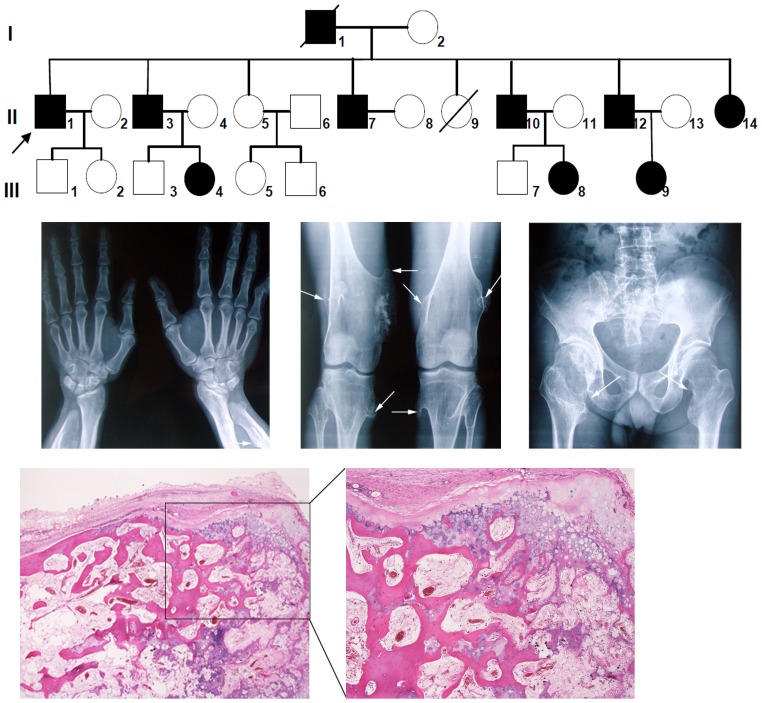
Hereditary and clinical features of a Chinese family with HME.(A) Pedigree of the family with HME. Arrow indicates the proband. Filled circles and squares indicate affected individuals. Open circles and squares indicate normal individuals. Oblique lines indicate the deceased. (B) Postero-anterior positioned radiograph of exostoses (indicated by arrows) in some severely affected individuals. Left image shows the exostosis in juxtaepiphyseal region of right ulna. Middle image shows multiple exostotic lesions in the femur, tibia, and fibular of both lower limbs. Right image depicts excrescences in metaphyseal regions of the femur both sides proximally. (C) Histological lesions of chondrosarcoma in proband under different magnifications (hematoxylin-eosin (HE) stain). One chondrosarcoma site is shown.